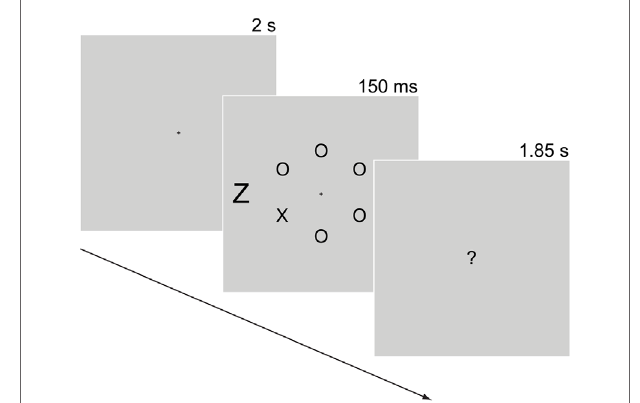
FigUre 1 | response competition task . Trials started with a 2-s fixation cross. Next, six letters appeared in a circular arrangement (2° in radius) containing one of two target letters (“X” or “Z” subtending 0.6° × 0.4°) and five non-target letters (all Os). Participants searched for the target letter among the non-target letters. The target letter was equally likely to appear on any of the six positions of the circle. A distractor-letter (subtending 1° × 0.6°) that was equally likely to be congruent (e.g., distractor “X” when target was “X”) or incongruent (distractor “Z” when the target was “X”) with the target letter appeared 3.5° to the left or to the right of the fixation point. A display with “?” at the center appeared after the stimulus display for 1.85 s during which participants responded to the target letter by pressing 0 for “X” or 2 for “Z” using the numerical keypad. An auditory tone (“beep”) was used as feedback for incorrect responses. An example trial sequence in the incongruent condition is shown here. Display durations appear above each display. Stimuli are not drawn to